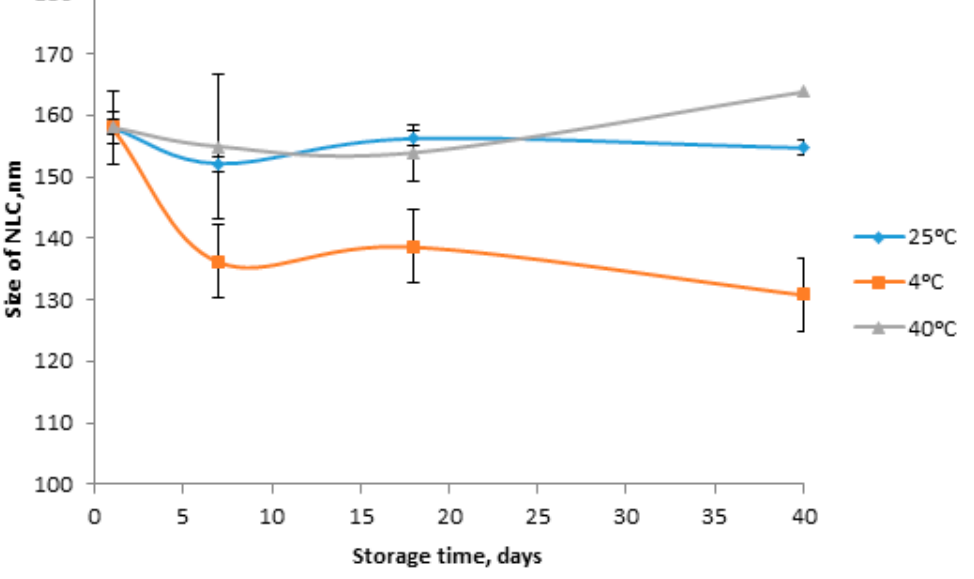
Figure 4. Changes of FDNLC particle size during storage at 4 ◦ C, 25 ◦ C and 40 ◦ C throughout 40 days of study. Experiments were done in triplicate ( n =